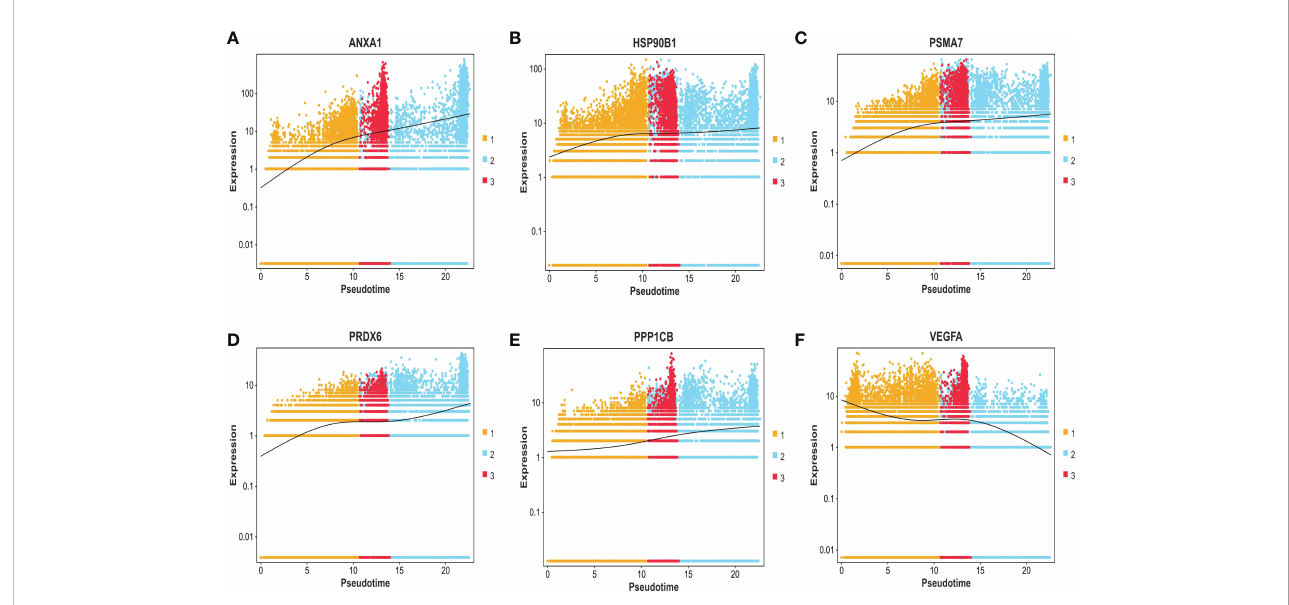
FIGURE 9 (A – F) The expression trend of ANXA1, HSP90B1, PSMA7, PRDX6, PPP1CB, and VEGFA genes based on the pseudo-time